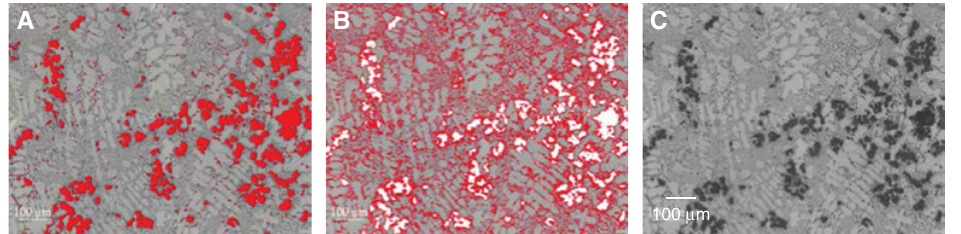
Figure 6 Volume fractions of each phase by image analysis software: (A) SiC particles 11.22%, (B) eutectic phase 22.90%, and (C) α -Al dendrite phase 65.88%.